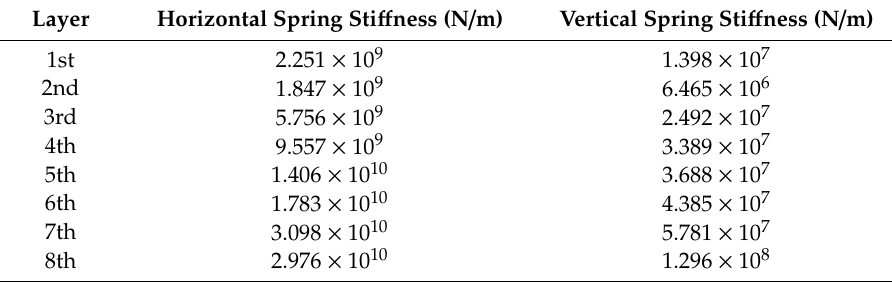
Table 5. Spring sti ff Table 5. Spring stiffness.